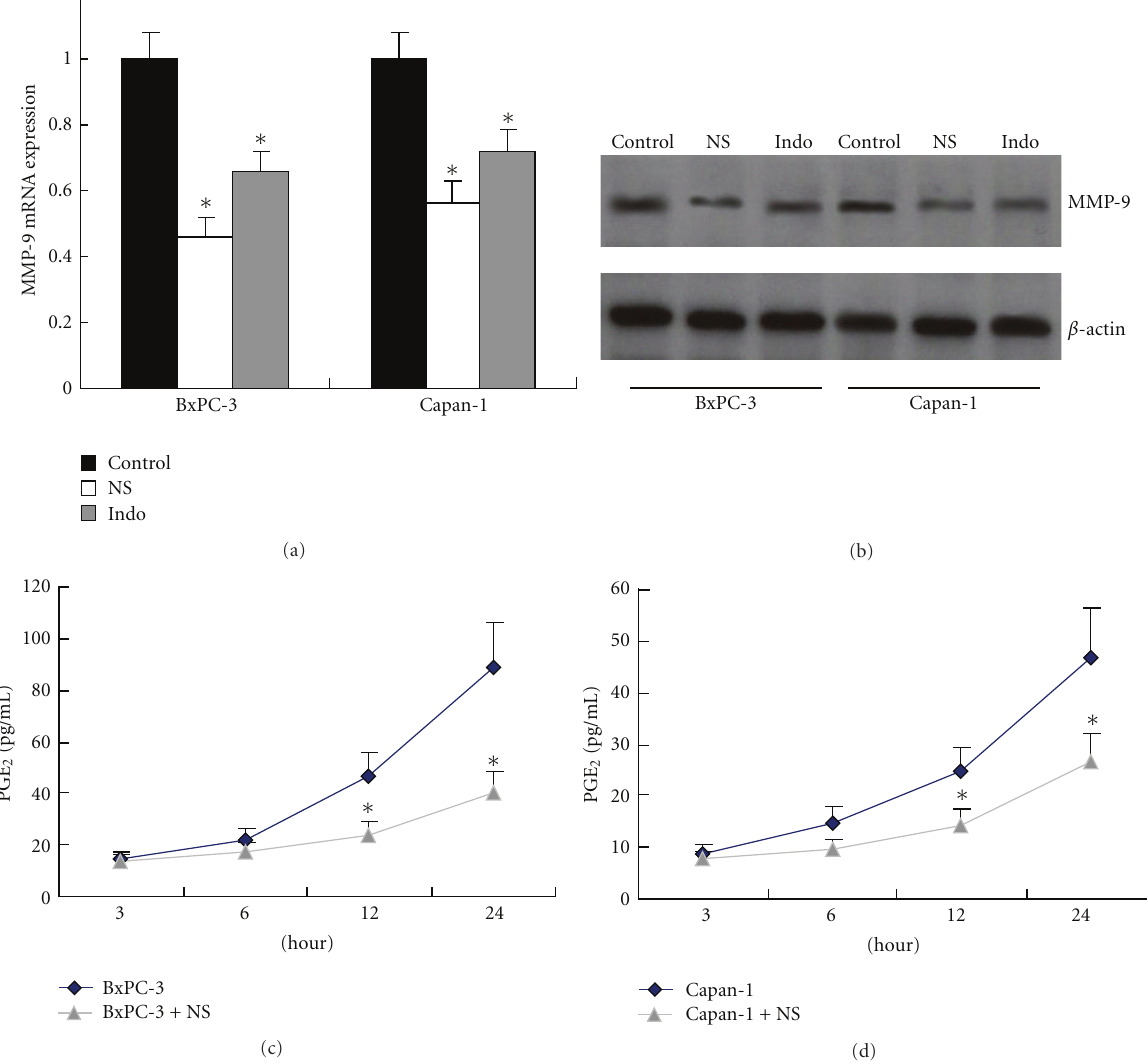
plays a key role in fever, one of the most common signs of inflammatory diseases, and the decrease of its level by inhibition of COX-2 expression can lead to a suppression of the